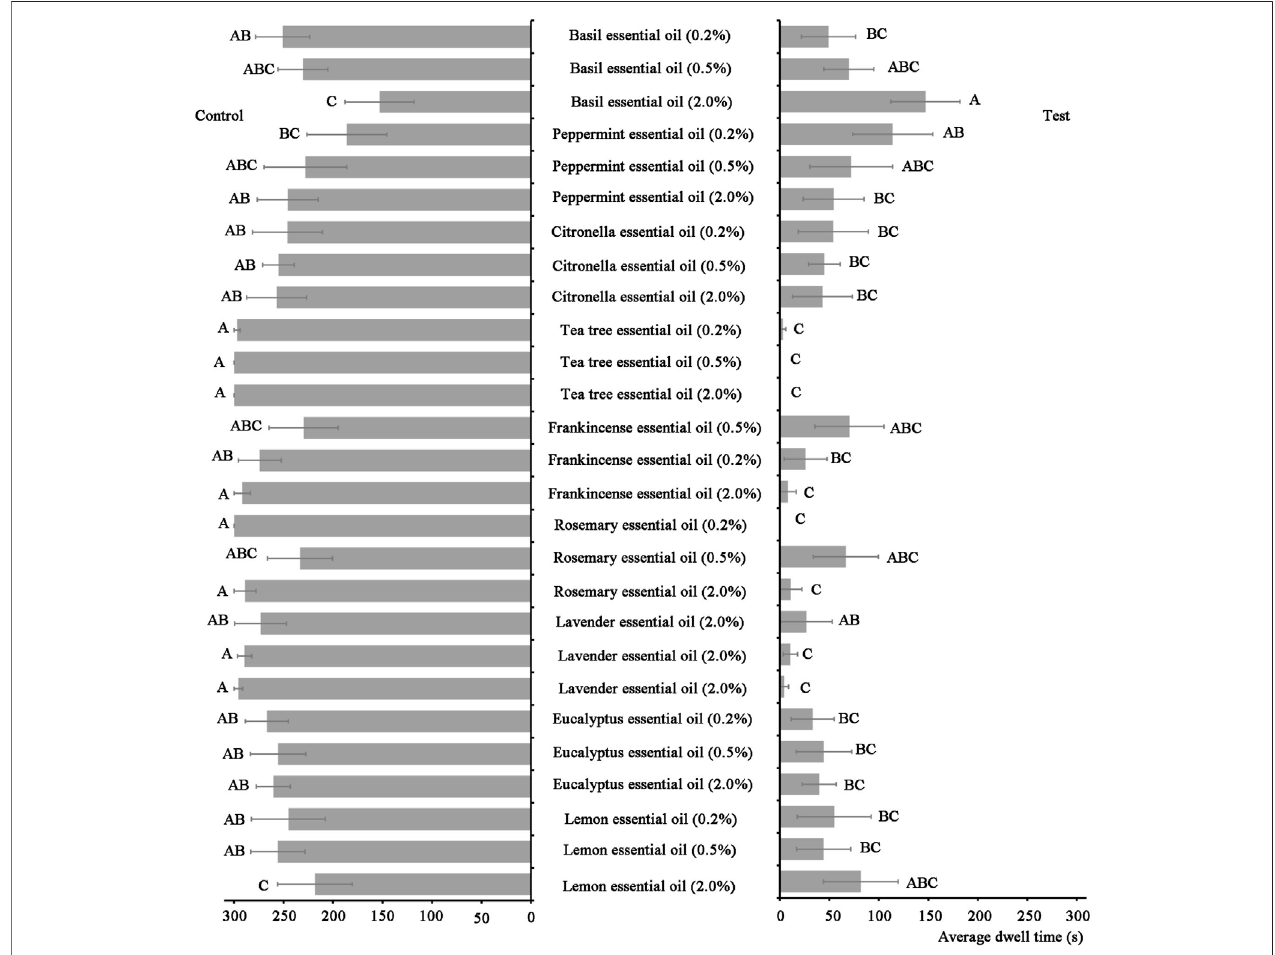
FIGURE1| Anaveragedwelltimeofarmywormlarvaeindifferentplantessentialoils.Differentcapitalletters inthe fi gureindicatesigni fi cantdifferencesinthemean residence time of each concentration of plant essential oil treatment at p < 0.05.